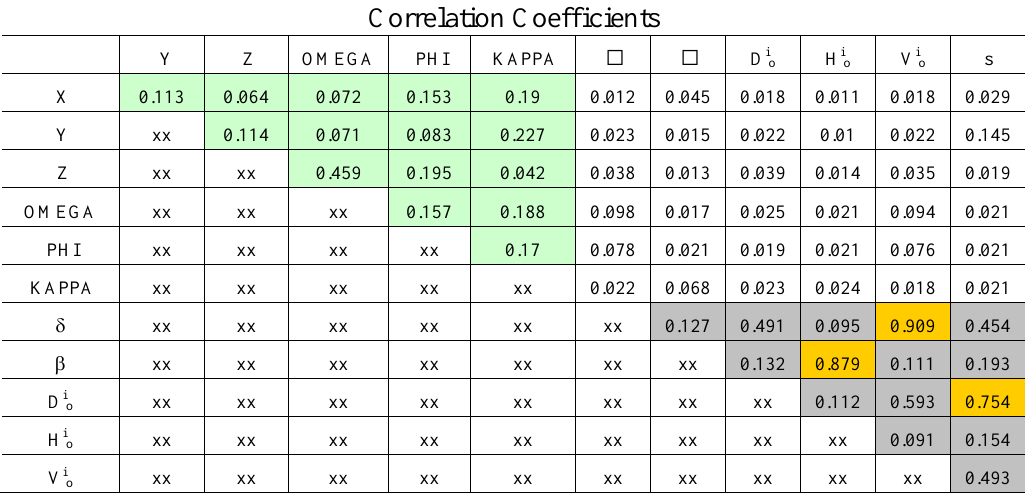
Table 5. Correlation Coefficients Between Estimated